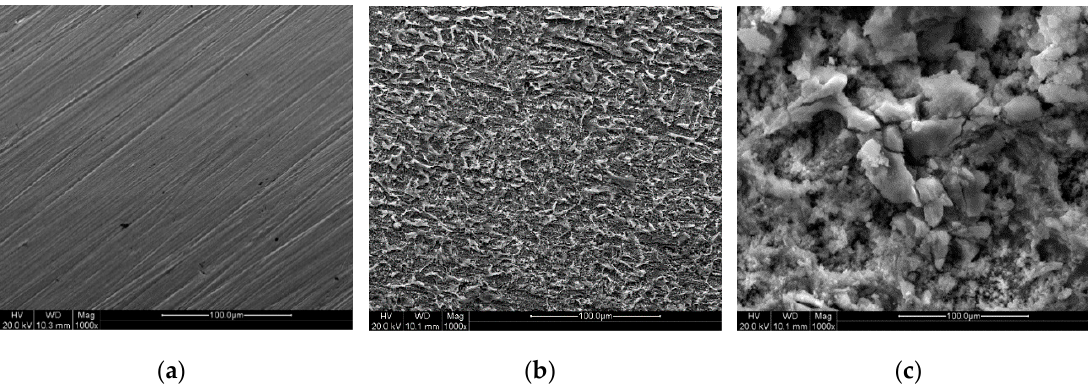
Figure 12. Scanning electron microscope (SEM) images of ( a ) blank and corroded surfaces, ( b ) 323 K, ( c ) 1000 rpm.